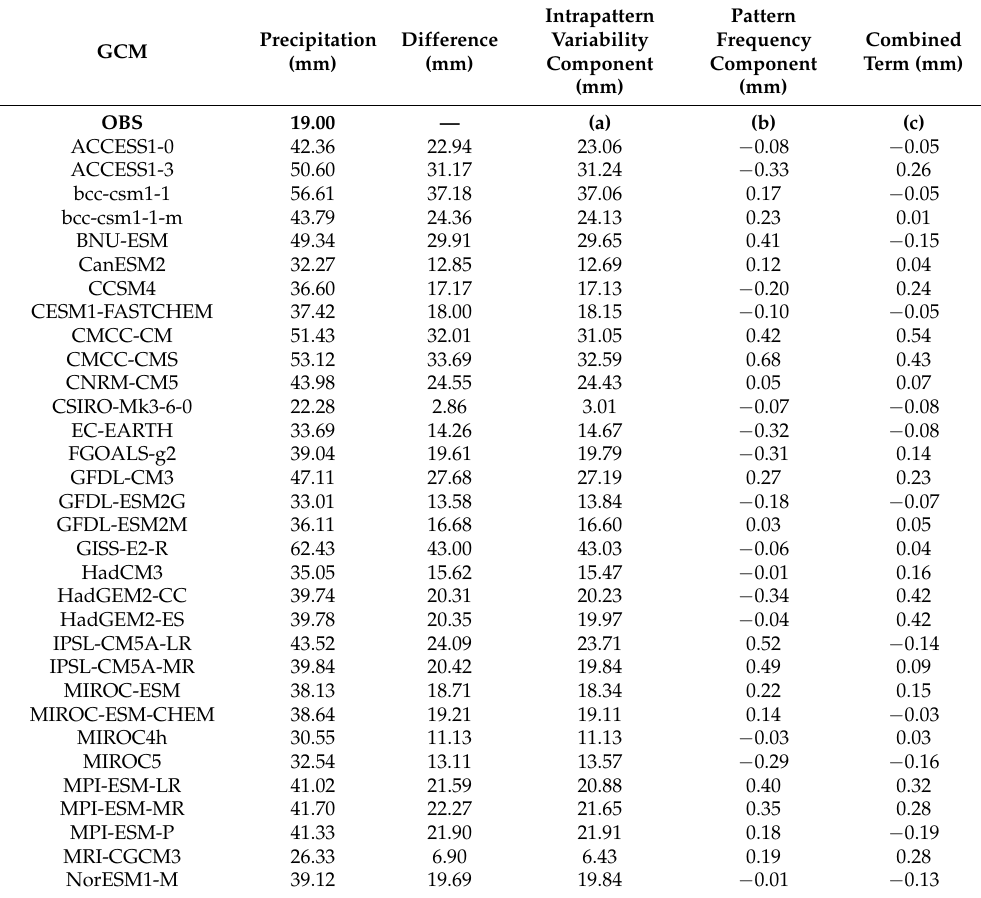
Table 4. Attribution of China’s precipitation difference between OBS and the individual GCMs in winter.